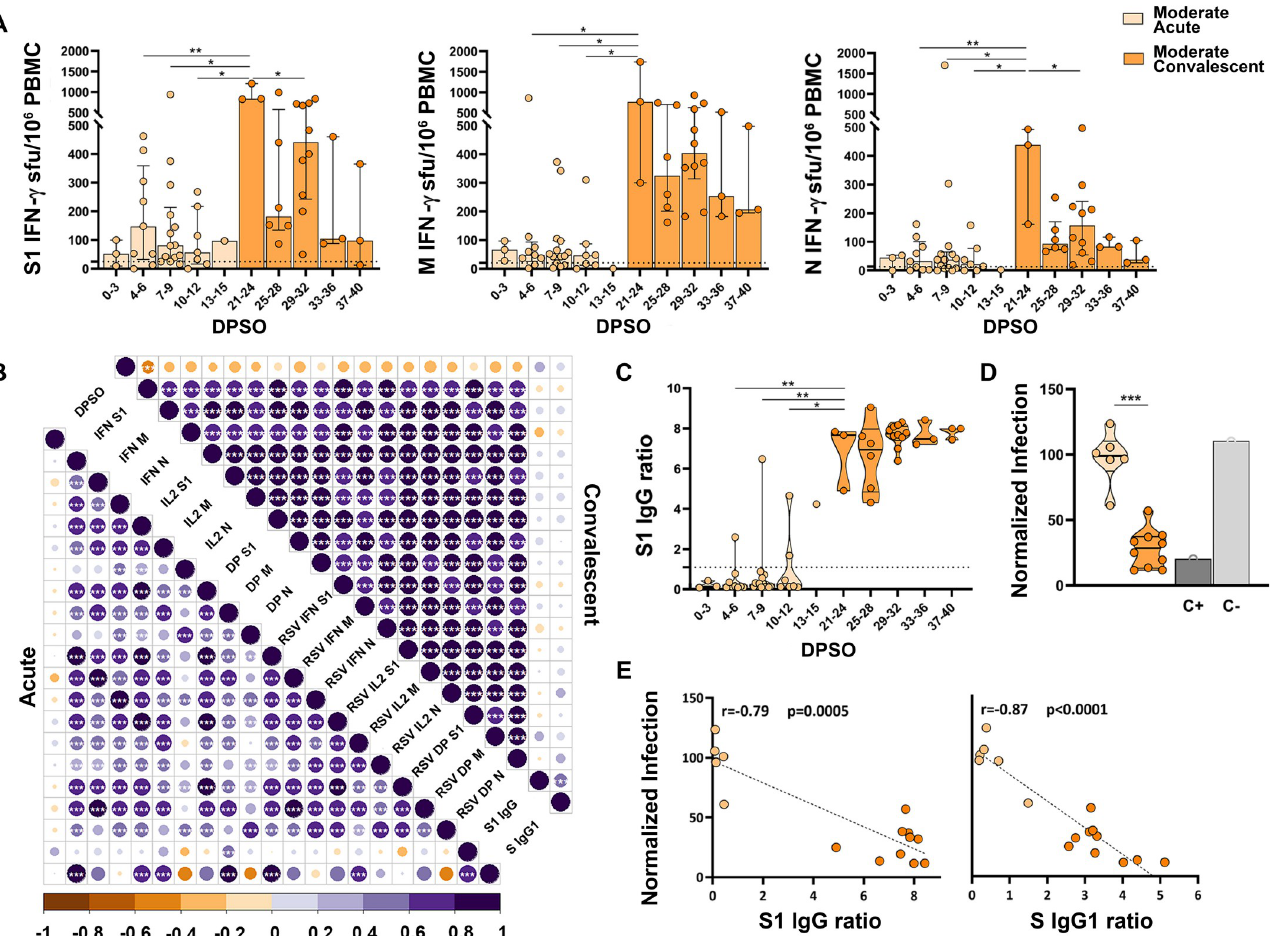
Fig 3. Cellular and humoral immune responses in moderate natural infection, during acute and convalescent phases. ( A ) FluoroSpot IFN- γ responses against SARS-CoV-2 S1, M and N proteins according to the days post-symptom onset (DPSO). Dashed lines represent the positivity cut-off established by using a non- infected control group: > 25 sfu/10 6 PBMC for S1, > 21sfu/10 6 PBMC for M and > 14sfu/10 6 PBMC for N. ( B ) Correlation matrices of cellular and humoral immune response variables analyzed. Only significant correlations (p < 0.05) are represented with asterisks. ( C ) Results of SARS-CoV-2 S1 IgG ELISA according to DPSO. ( D ) Neutralizing capacity tested with S protein-pseudotyped virus represented as percentage of normalized infection neutralized. ( E ) Correlation between neutralizing capacity and the semi-quantitative results of SARS-CoV-2 IgG ELISA (left) and anti-Spike IgG1 assessed by flow cytometry (right). Linear regressions were performed using Spearman’s rank test. Horizontal bars and whiskers represent median values and interquartile ranges, respectively. The significance between groups was determined using Mann Whitney or Wilcoxon signed rank tests, � p < 0.05, �� p < 0.01, ��� p < 0.001, ���� p < 0.0001. (See Fig 2 footnote for more detailed